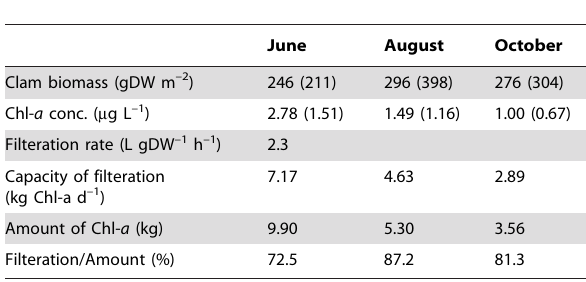
Table 3. Estimation of the rate of filtration by the clam ( Ruditapes philippinarum ) in Hichirippu Lagoon during productive